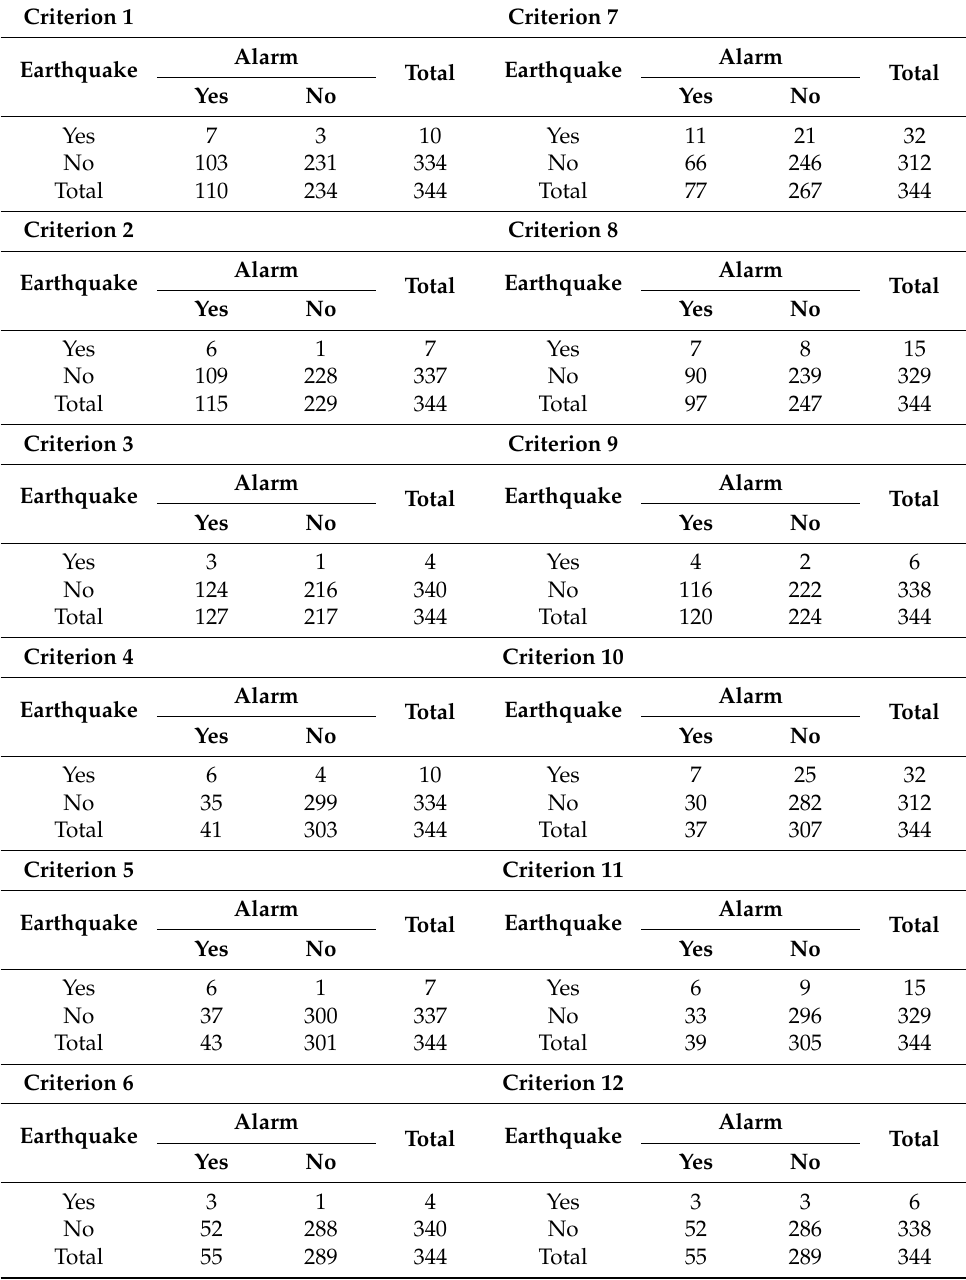
Table 5. The cross-tabulation tables based on twelve